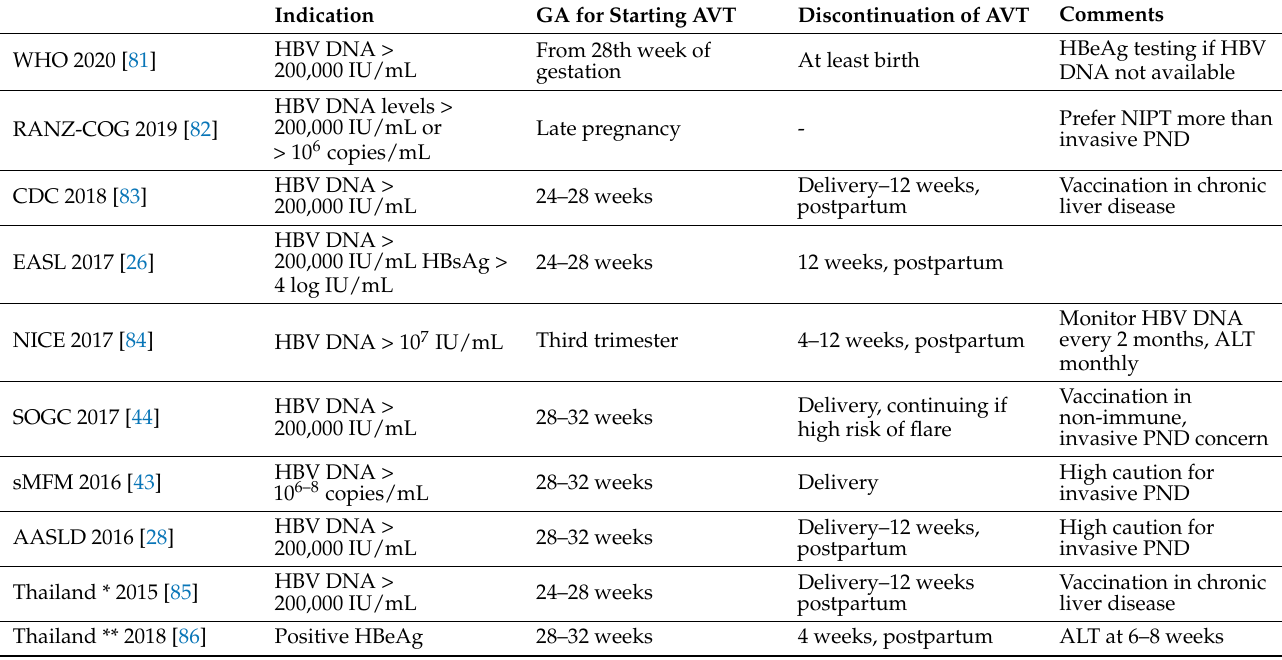
*/** Representing geographical area of high prevalence (Thailand: Department of Disease Control/Thai Association for the Study of the Liver); AASLD: American Association for the Study of Liver Diseases; sMFM: Society for Maternal-Fetal Medicine; RANZCOG: Royal Australian and New Zealand College of Obstetricians and Gynecologists; EASL: European Association for the Study of the Liver; GA: gestational age; NICE: UK’s National Institute for Health and Care Excellence; NIPT: Non-invasive prenatal test; SOGC: Society of Obstetricians and Gynecologists of Canada; CDC: Centers for Disease Control; WHO: World Health Organization; PND: prenatal